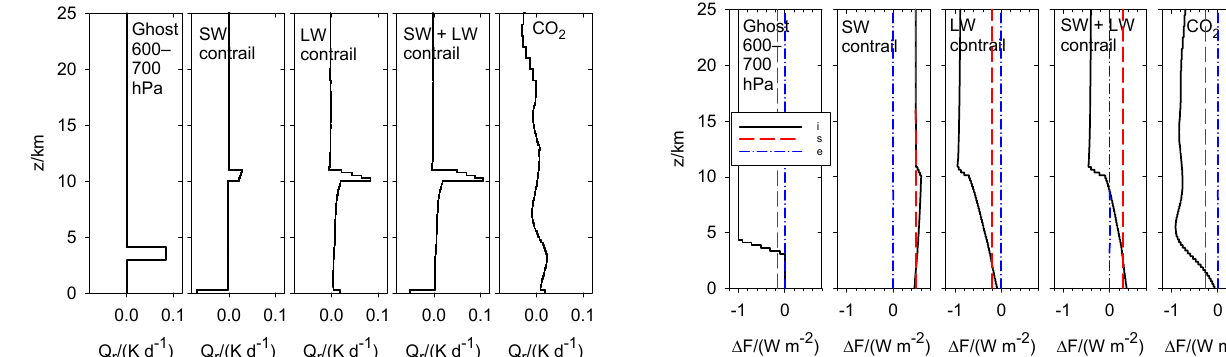
Figure 4. Initial radiative heating rates H(t = 0 ,z) versus height z for a ghost forcing example, for SW, LW, and SW + LW contrail cirrus and for a CO 2 disturbance. For plotting, the local heating rate induced by the nonzero radiative fluxes at the fixed-temperature sur- face is distributed over the lowest 275m height (same heat capacity as 1km thick cirrus layer at lower pressure).